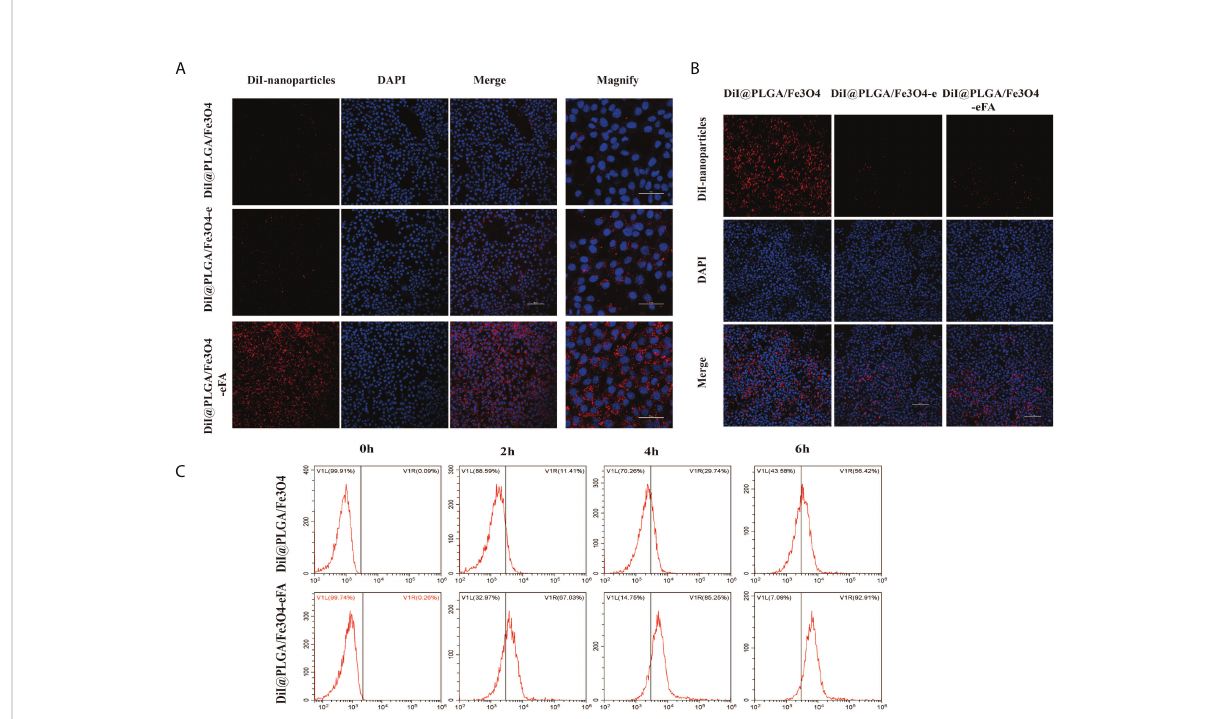
FIGURE 3 In vitro 4T1 cell-targeting behavior of PFH/ART@PLGA/Fe